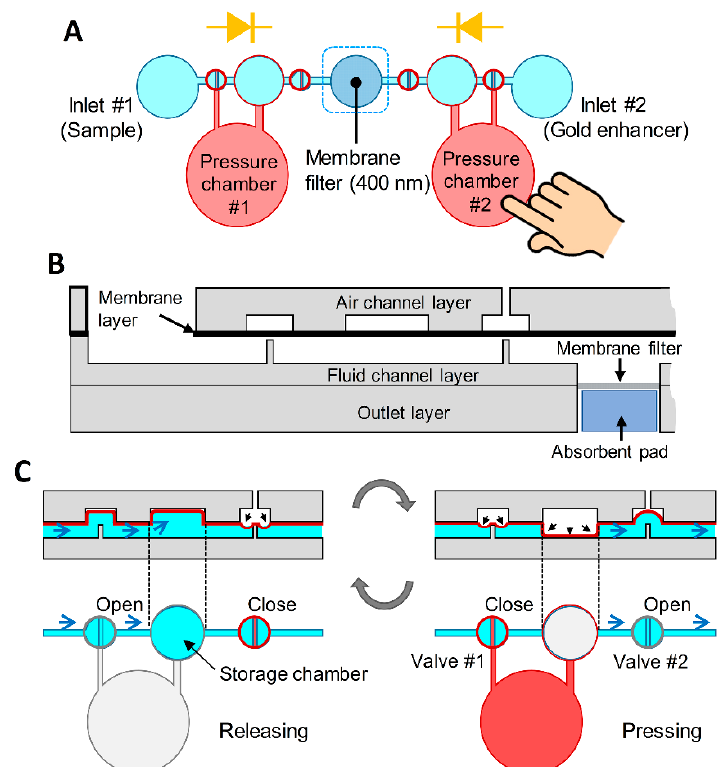
Figure 1. Design and working principle of the device. (A) Schematic of the device. (B) A membrane filter and an absorbent pad were embedded in the device to wash out unbound free magnetic nanoparticles (MNPs). (C) Working principle of the finger-powered microfluidic pump when the pressure chamber is pressed or released.